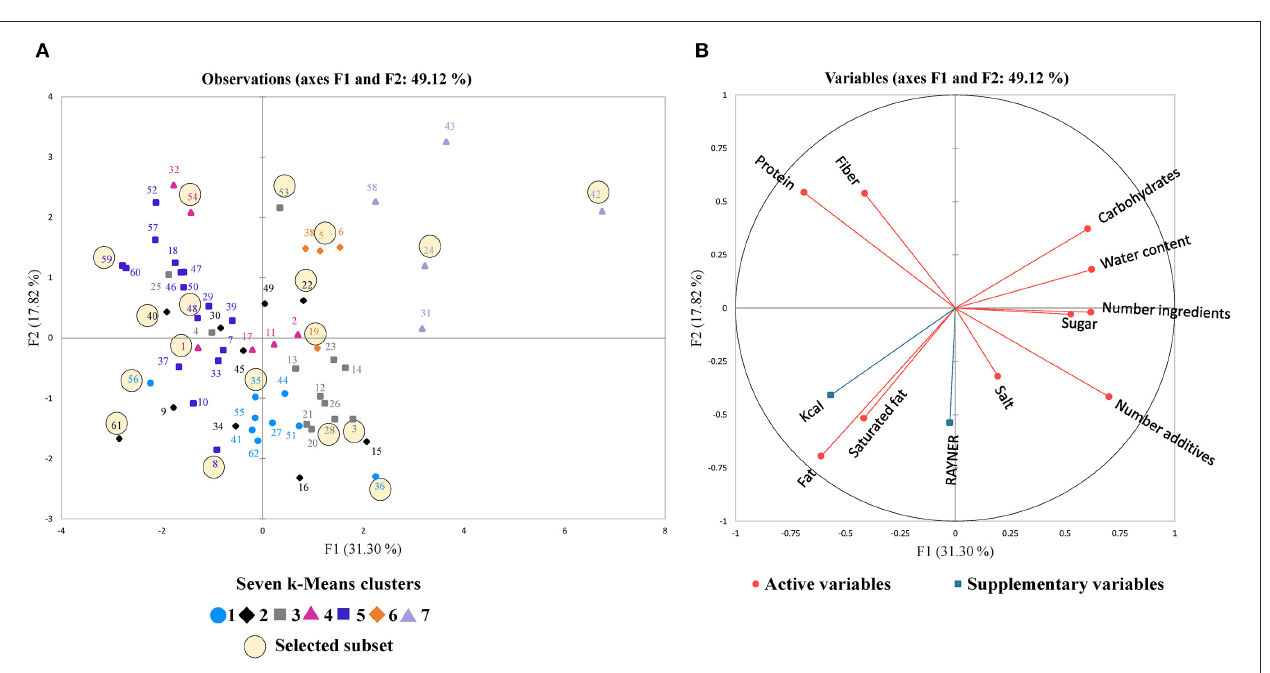
FIGURE 5 | Principal component analysis (PCA) with axes F1 and F2. (A) observation plot including 62 cookies with chocolate inclusion colored based on seven different K-means clusters and the 18 selected cookies for the subset in black circles, representative of the market. (B) PCA correlation matrix with 10 active